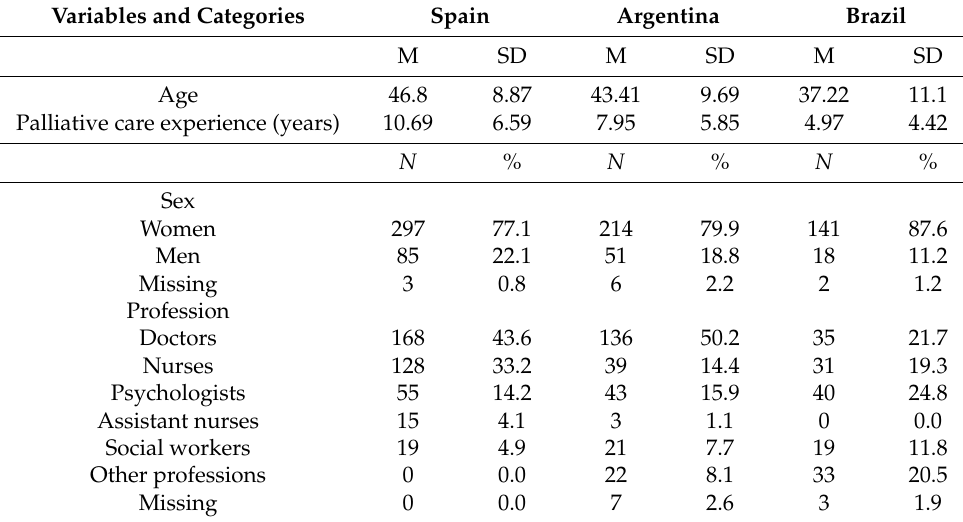
Table 1. Sociodemographic characteristics of the participants. Variables and